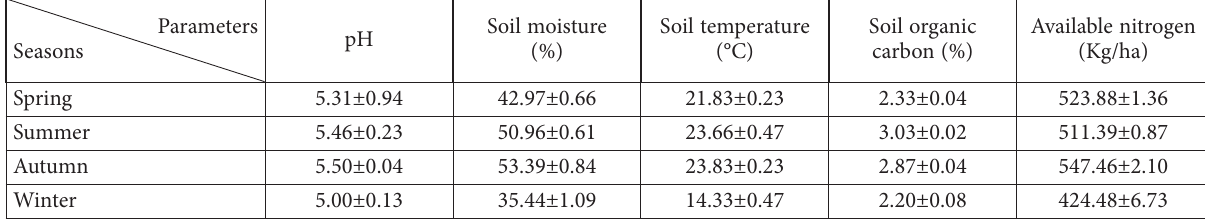
Table 1. Seasonal variation in physico-chemical characteristics of soil at FRS